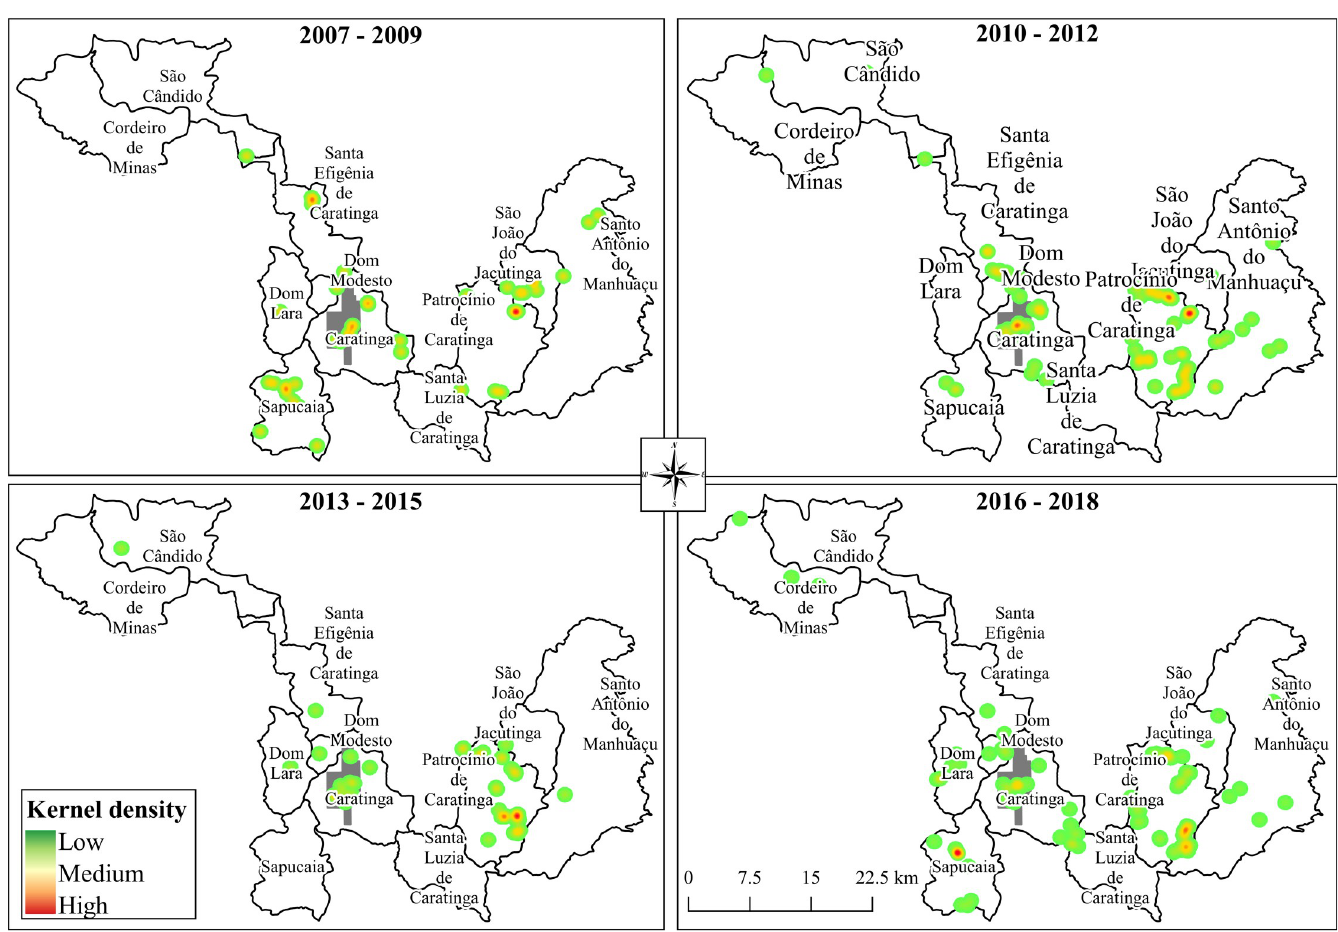
Fig 6. Kernel density of ATL cases in the municipality of Caratinga